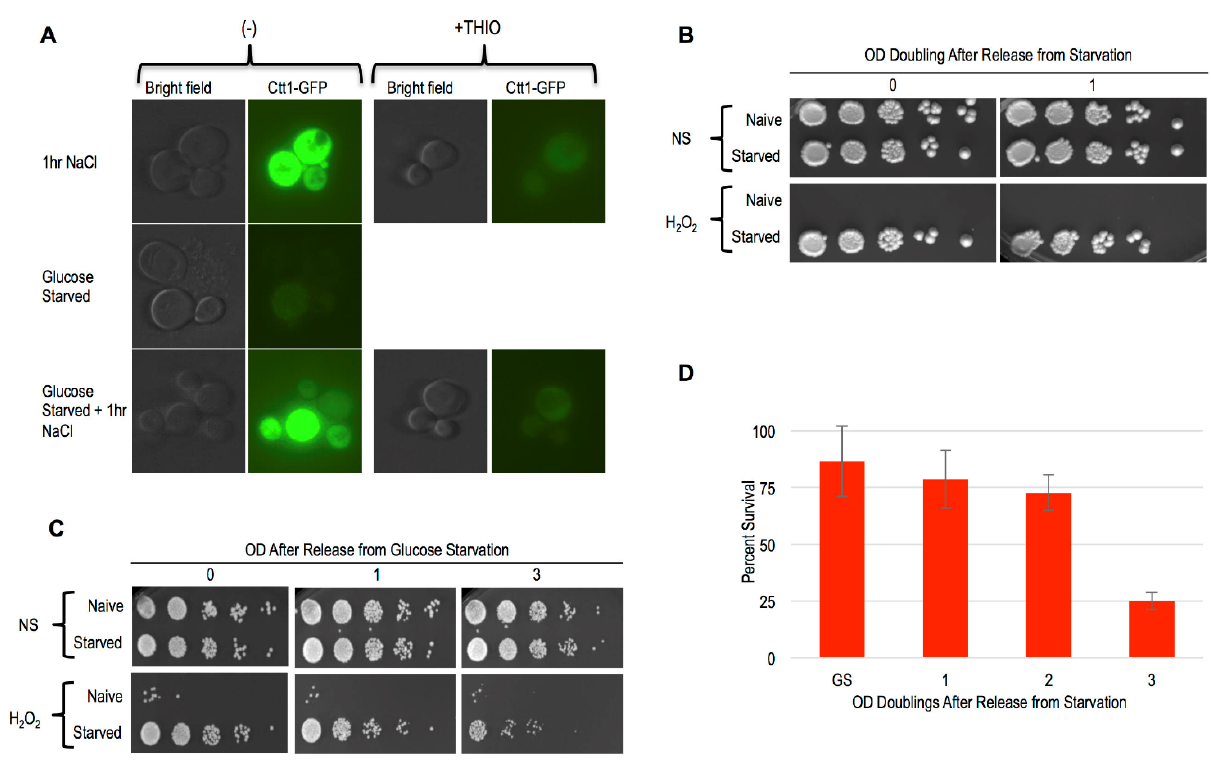
FIGURE 6: Ctt1 and Msn2/4 are not involved in starvation induced cellular memory. (A) Representative images of a CTT1-GFP strain after 1 hour of NaCl exposure, 12 hours of glucose starvation (Starved), or 12 hours of glucose starvation + 1 hour of NaCl treatment (Starved + 1hr NaCl) are shown in the left panels. The right panels show the same cells treated with thiolutin concurrent with NaCl exposure. (B) A ctt1 ∆ strain was compared with an isogenic WT strain for starvation induced cellular memory. Survival of WT and ctt1 ∆ cells to H 2 O 2 exposure using spot tests is shown. (C) H 2 O 2 stress resistance spot assay of 12 hours glucose starvation (Starved) and mid-log cells (Naive) of a WT and msn2 Δ msn4 Δ strain. (D) Survival of msn2 ∆ msn4 ∆ cells released from glucose starvation and exposed to H 2 O 2 was quantified. Error bars represent 1 standard error of the